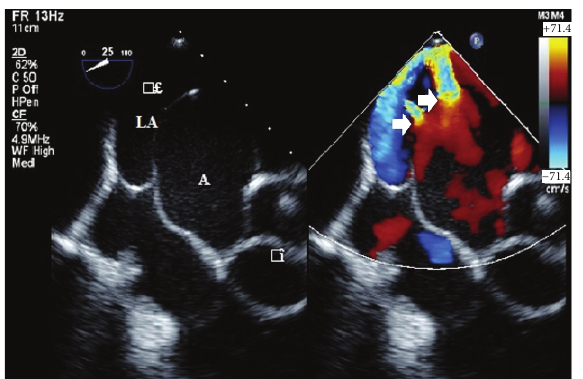
Figure 1: TEE showing fistulous communication (arrow) between sinus of valsalva aneurysm (A) and left atrium